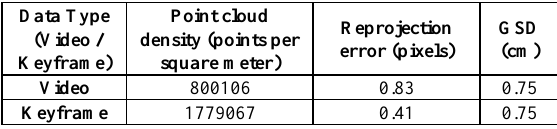
Table 5. The output results of the thermal infrared dense point cloud generation for the test dataset.